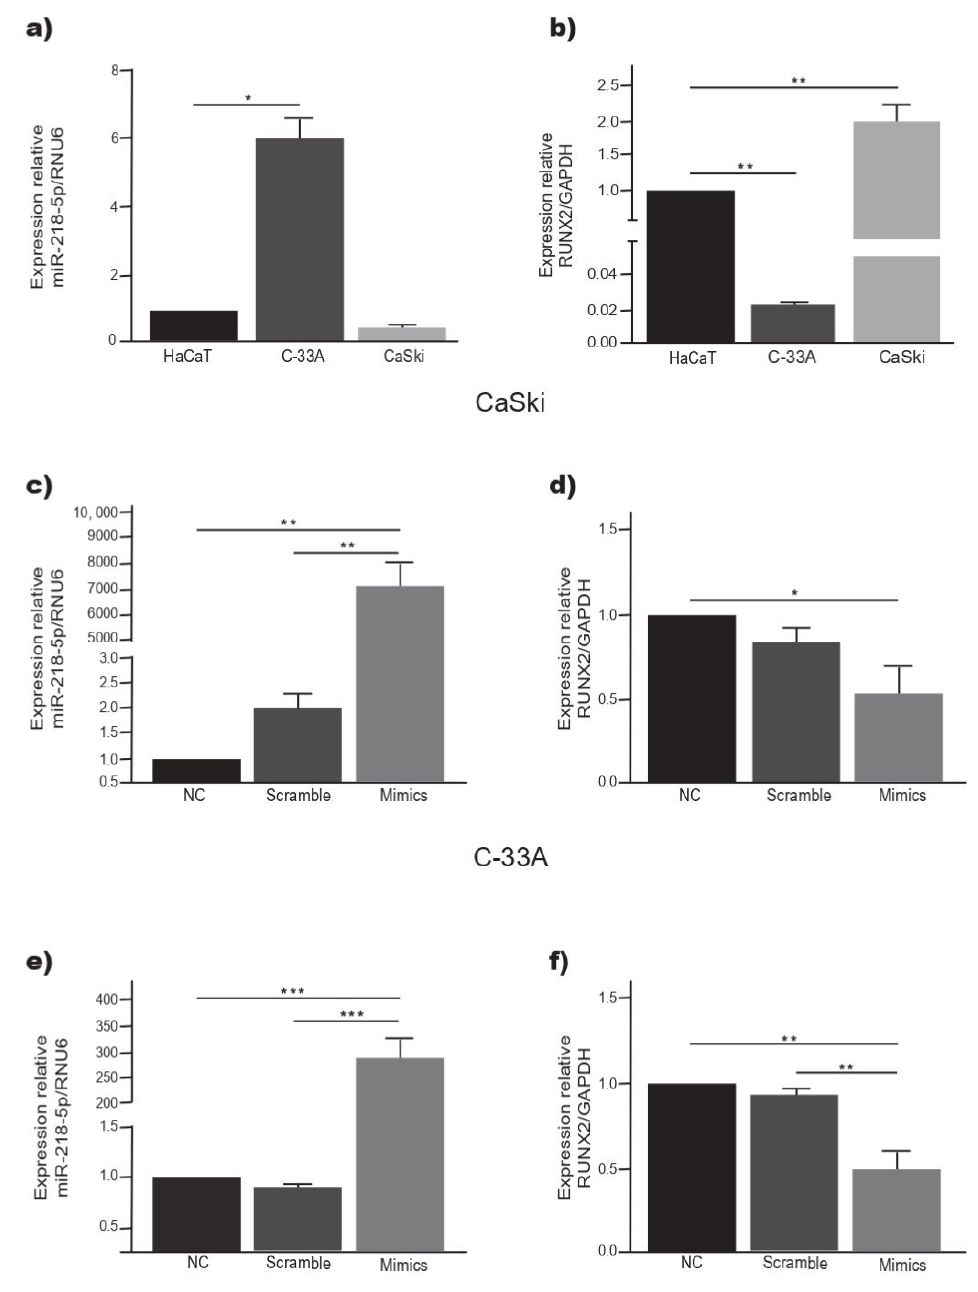
Figure 5. miR-218-5p overexpression is related to a decrease in the RUNX2 level. ( a ) Basal expression of miR-218-5p in HaCaT, C-33A and CaSki cells. ( b ) Basal level of RUNX2 in HaCaT, C-33A and CaSki cells. ( c ) miR-218-5p level and ( d ) RUNX2 expression in CaSki cells transfected with miR-218-5p mimic. ( e ) miR-218-5p expression and ( f ) RUNX2 level in C-33A cells transfect with miR-218-5p mimic. * p < 0.05, ** p < 0.01, *** p < 0.001.